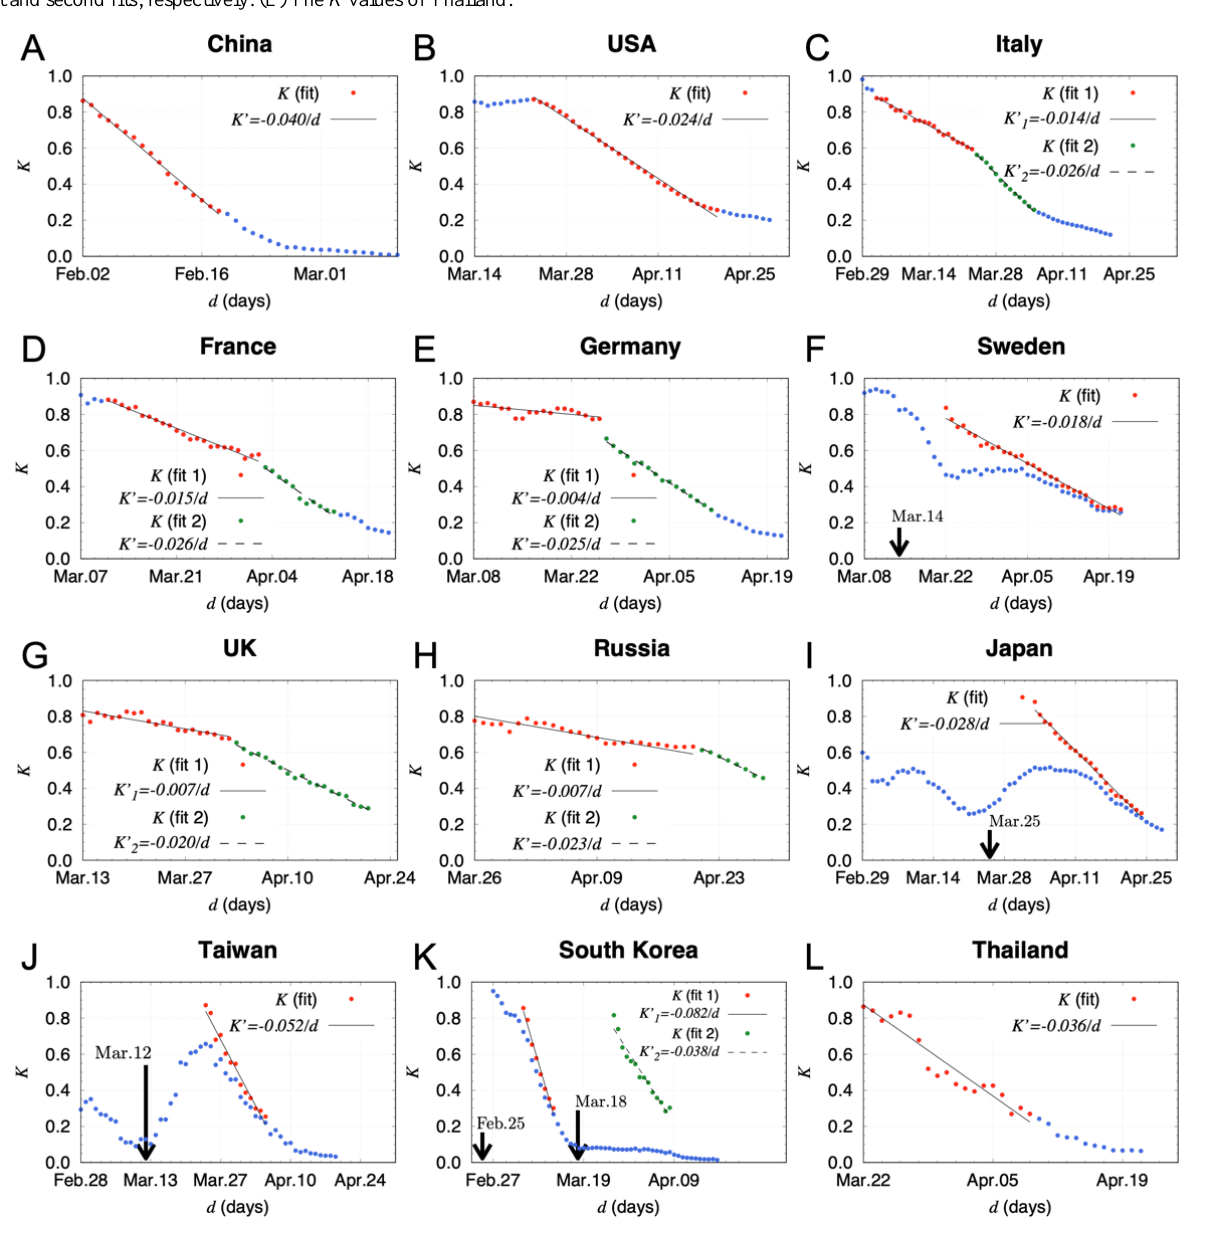
Figure 1. Transition of the K values from February to April 2020. (A) The K values of China obtained from the daily total number of infected people. The slope K’ was obtained by a linear fit in the range of 0.25< K <0.9. The data points used for the fit are indicated by red points. The solid line is the fit result. (B) The K values of the United States. (C) The K values of Italy. The first and second K’ values were obtained by linear fits using the red and green points, respectively. The solid line is the result of the first fit. The dashed line is the result of the second fit. (D) The K values of France. (E) The K values of Germany. (F) The K values of Sweden. The total number of infected people was counted from the reference date set for March 14. (G) The K values of the United Kingdom. (H) The K values of Russia. (I) The K values of Japan. The reference date was set for March 25. (J) The K values of Taiwan. The reference date was set for March 12. (K) The K values of South Korea. The reference dates were set for February 25 and March 18 for the first and second fits, respectively. (L) The K values of